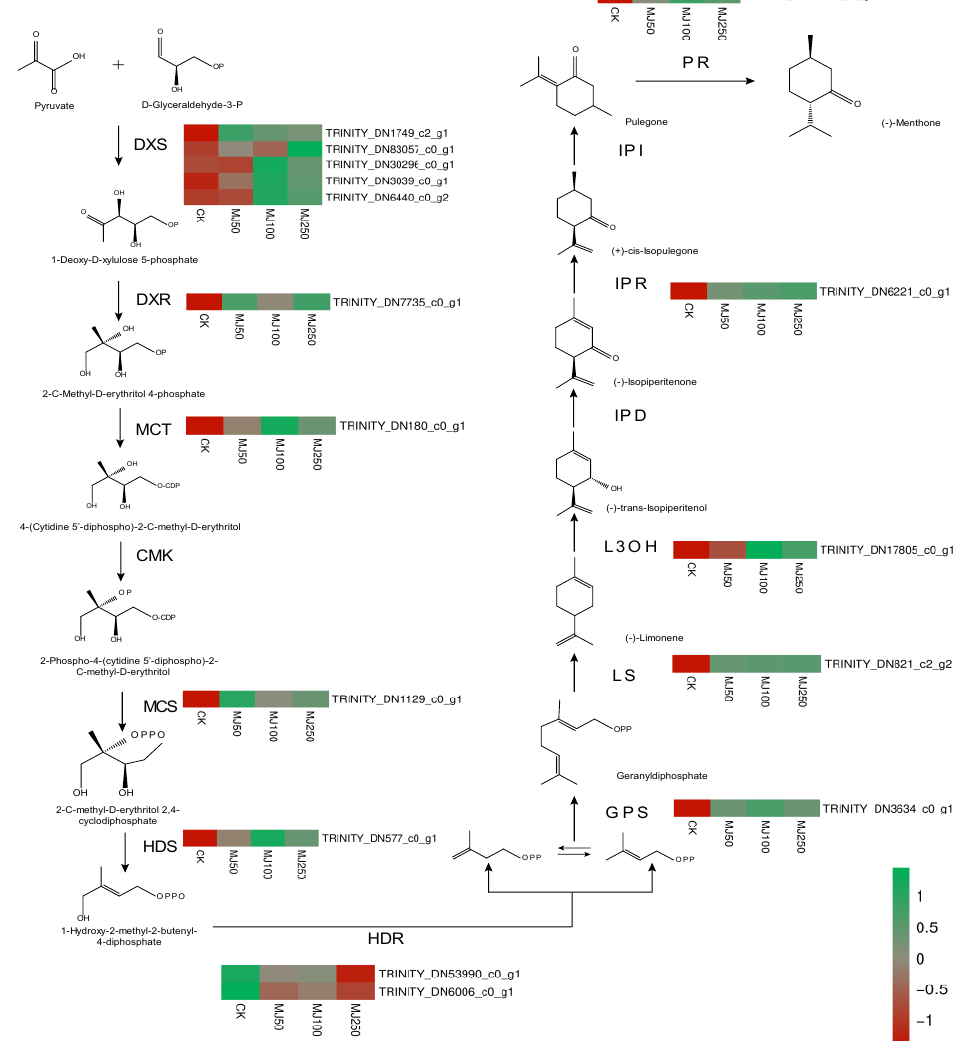
Figure 6. Monoterpenoid synthesis − related differentially expressed genes. Enzyme abbreviations: DXS 1 − deoxy − D-xylulose − 5 − phosphate synthase; DXR 1 − deoxy − D − xylulose − 5 − phosphate reductoi-